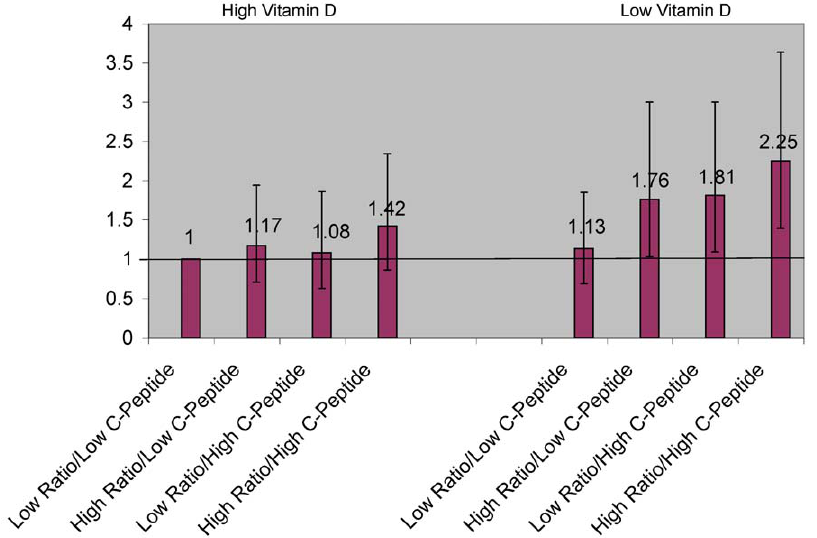
Figure 1. Multivariate odds ratios and 95% confidence intervals of colorectal cancer by different combinations of plasma 25(OH)D, IGF-1/IGFBP3 ratio (ratio) and C-peptide (high=above or equal median; low = below median), HPFS and NHS combined.